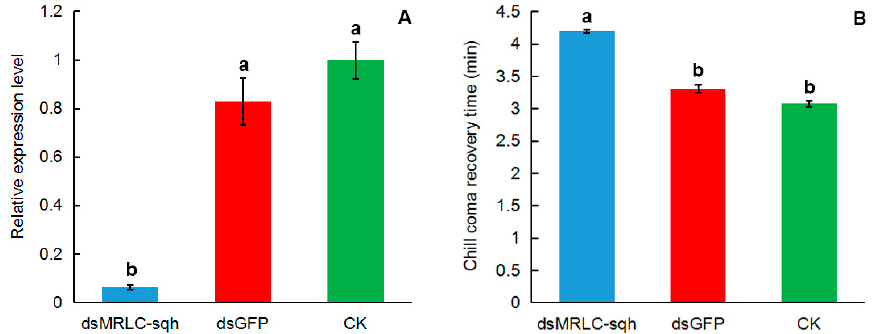
Figure 6. Relative expression levels of MRLC-sqh ( A ) and chill-coma recovery time (CCRT) ( B ) in O. communa after double-stranded RNA (dsRNA) treatment. CK represents the untreated controls. The expression fold changes were related to the CK. The transcript level of MRLC-sqh was normalized against that of RPL4 . Relative expression is represented as mean ± SE. The bars marked with different lowercase letters are significantly different based on one-way ANOVA and LSD analyses.